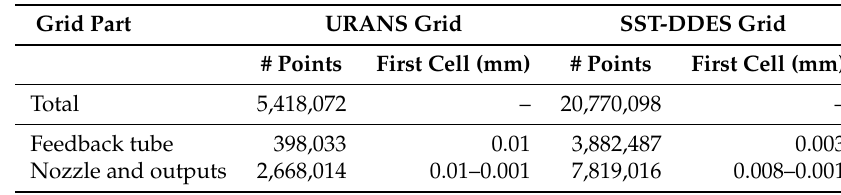
Table 1. Grid parameters for the URANS and SST-DDES grid cases.